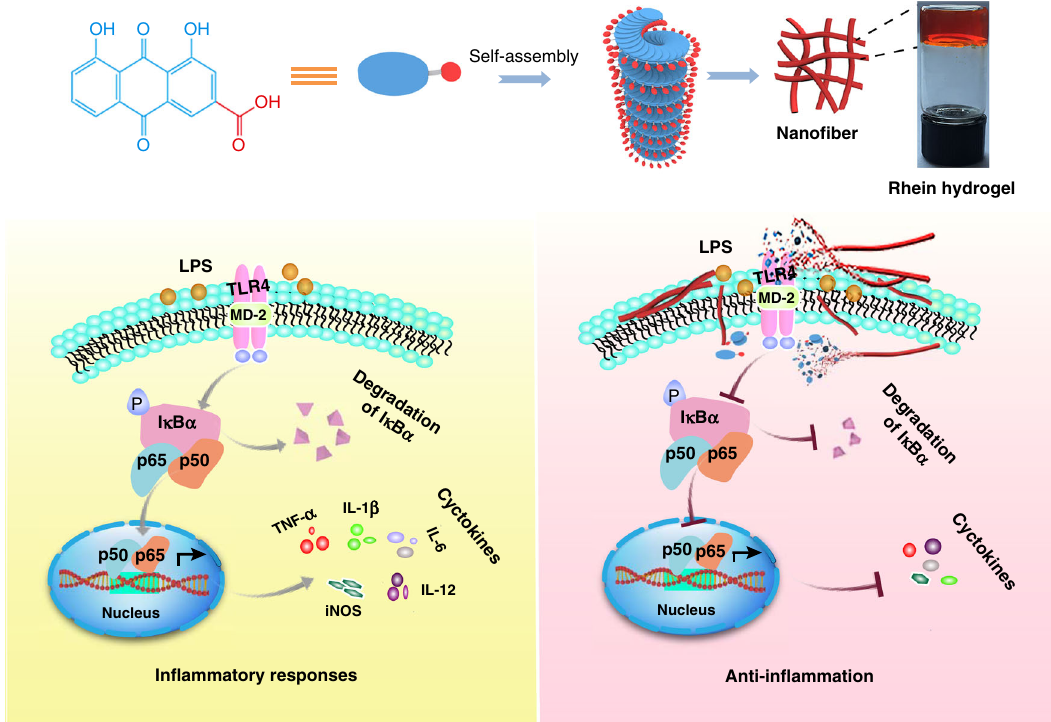
Fig. 7 Schematic depiction of neuroin fl ammatory prevention induced by rhein hydrogel. Rhein is self-assembled by non-covalent interaction to form nano fi bers with left-handed, which are further crosslinked to form 3D network structure. When treating in fl ammatory BV2 cells with rhien nano fi bers, the nano fi bers slowly depolymerize to release rhein or rhein aggregates. They intensively bind to MD-2 (the subunit of TLR4 receptor), obscure the active site of TLR4 and further block the access of the substrate, leading to the inhibition of NF κ B activation. Subsequently, the rhein hydrogel suppresses the release of neuroin fl ammatory factors and